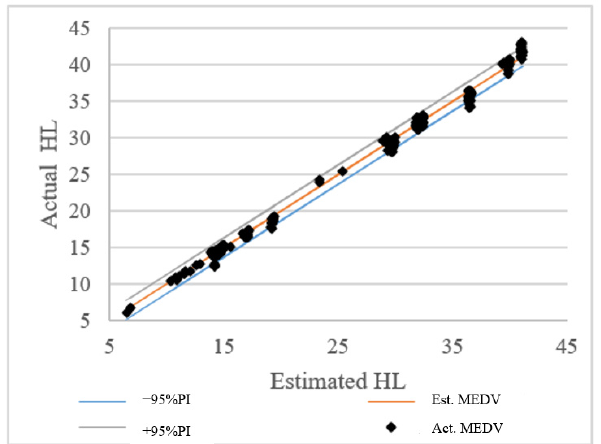
Figure 5. Prediction interval ( PI ) for testing data: Experiment 9.